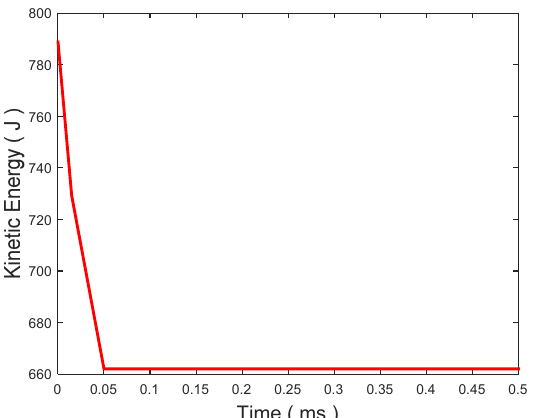
Figure 10. Energy absorption obtained from LS DYNA simulation for 200 m/s impact velocity for target thickness of 3.18 mm.